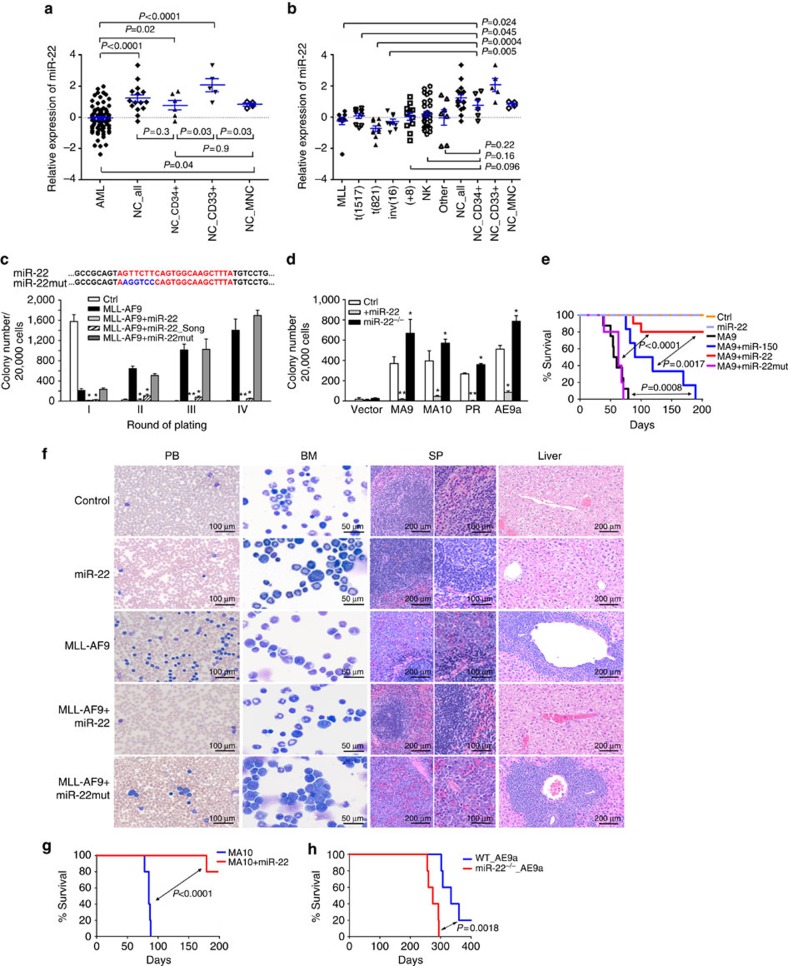
miR-22 inhibits AML cell transformation and leukemogenesis.(a,b) Exiqon microRNA profiling assay showed that miR-22 is significantly (P<0.05) downregulated in the entire set of AML set (n=85) (a) or each individual subset (b), relative to normal controls. The expression data were log(2) transformed and mean-centred. Mean±s.e.m. values were shown. (c) Comparison of effects of in-house miR-22, miR-22_Song16 and miR-22 mutant (miR-22mut; see the mutation sequence at the top) on MLL-AF9-induced colony forming. CFAs were performed using mouse BM progenitor (Lin-) cells transduced with MSCV-neo+MSCV-PIG (Ctrl), MSCV-neo-MLL-AF9+MSCV-PIG (MLL-AF9), or MSCV-neo-MLL-AF9+MSCV-PIG-miR-22/miR-22_Song/miR-22mut. (d) Effects of miR-22 on the colony forming induced by multiple fusion genes. CFA was performed using wild-type BM progenitor cells co-transduced with MSCV-neo-MLL-AF9 (MA9), -MLL-AF10 (MA10), -PML-RARA (PR) or -AML1-ETO9a (AE9a)19, together with MSCV-PIG (Ctrl) or MSCV-PIG-miR-22 (+miR-22), as well as miR-22−/− BM progenitors co-transduced with individual fusion genes and MSCV-PIG. Colony counts (mean±s.d.) of the second round of plating are shown. *P<0.05; **P<0.01. (e,f) Effect of miR-22 on MLL-AF9-induced primary leukemogenesis. Kaplan–Meier curves are shown for six cohorts of transplanted mice including MSCVneo+MSCV-PIG (Ctrl; n=5), MSCVneo+MSCV-PIG-miR-22 (miR-22; n=5), MSCVneo-MLL-AF9+MSCV-PIG (MA9; n=8), MSCVneo-MLL-AF9+MSCV-PIG-miR-150 (MA9+miR-150, n=6), MSCVneo-MLL-AF9+MSCV-PIG-miR-22 (MA9+miR-22; n=10) and MSCVneo-MLL-AF9+MSCV-PIG-miR-22mutant (MA9+miR-22mut; n=5) (e); Wright–Giemsa stained PB and bone marrow (BM), and hematoxylin and eosin (H&E) stained spleen and liver of the primary BMT recipient mice at the end point are shown (f). (g) Effect of miR-22 on MLL-AF10-induced primary leukemogenesis. Kaplan–Meier curves are shown for two cohorts of transplanted mice including MSCVneo-MLL-AF10+MSCV-PIG (MA10; n=5) and MSCVneo-MLL-AF10+MSCV-PIG-miR-22 (MA10+miR-22; n=5). (h) miR-22 knockout promotes AE9a-induced leukemogenesis. Kaplan–Meier curves are shown for mice transplanted with wild-type or miR-22−/− BM progenitor cells transduced MSCV-PIG-AE9a (n=5 for each group). The P values were generated by t-test (a–d) or log-rank test (e,g,h).